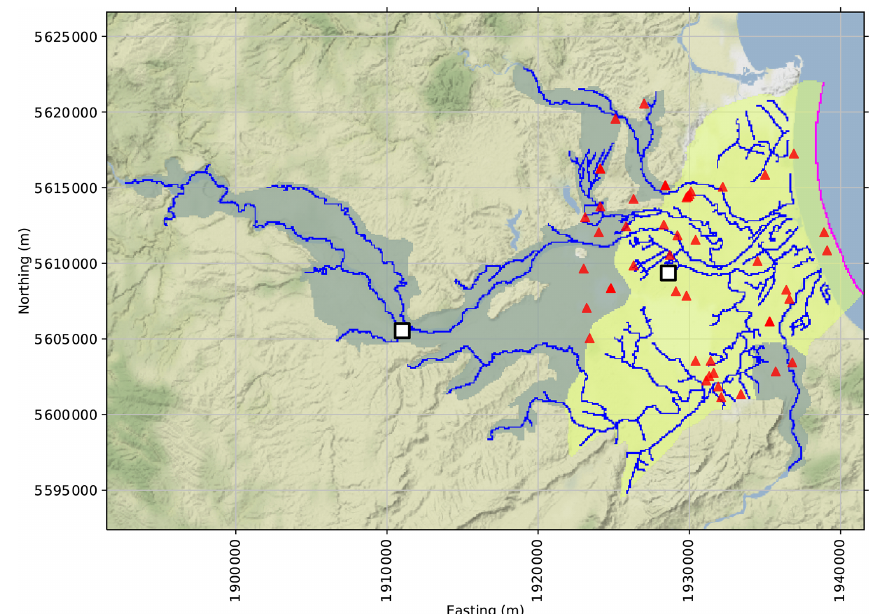
Figure 1. Heretaunga Plains model schematic, including the river boundary conditions (blue lines), top-layer confinement status (unconfined areas shaded blue and confined areas shaded yellow) and the coastal general-head boundary (magenta line). The location of groundwater tritium-derived MRT observations are shown as red triangles. The location of forecasts – spring discharge rates during summer and winter – are shown as white